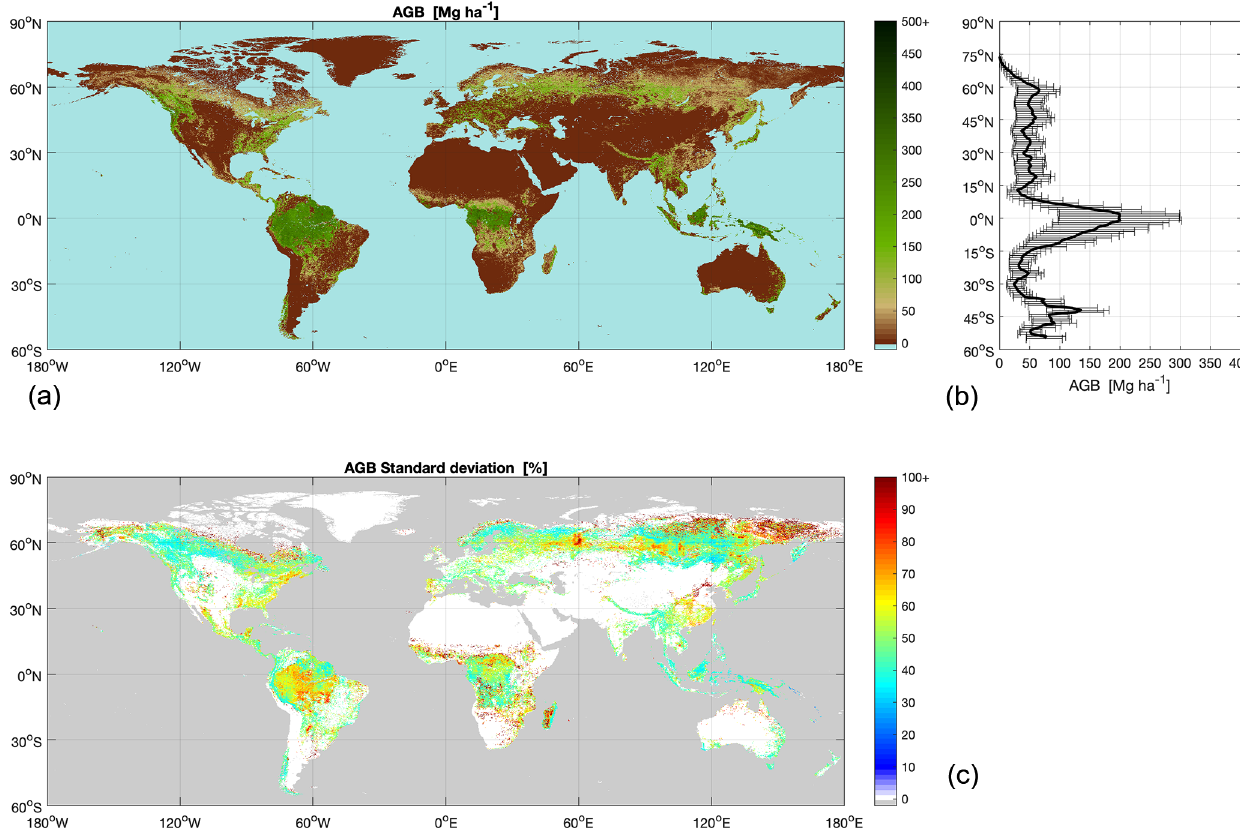
Figure 2. Map estimates of AGB (a) and AGB standard deviation expressed relative to the AGB (b) . The colour bar of the AGB map has been truncated at 500Mgha − 1 to increase contrast. Similarly, the colour bar of the AGB relative standard deviation has been truncated at 100%. The right-hand panel shows the profile of average AGB along latitude (thick solid line) and the two-sided average standard deviation of AGB at a given latitude (horizontal bars).